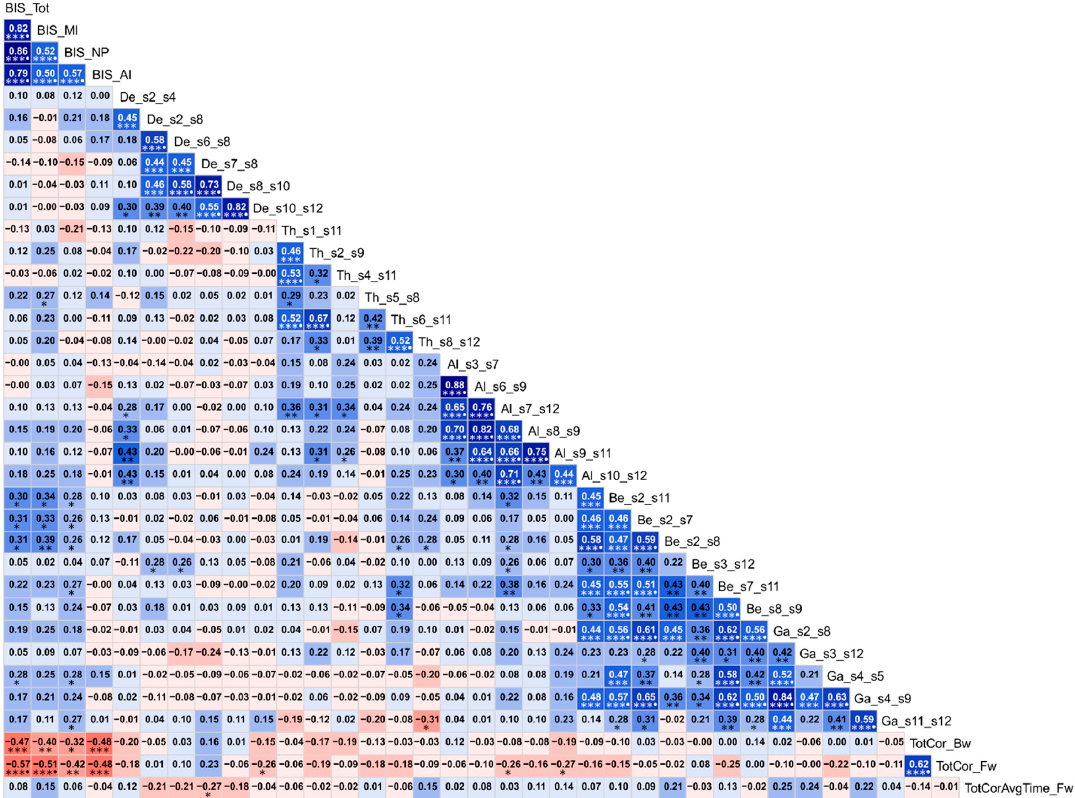
Figure 7. Correlation matrix showing associations among the top significant variables based on explorative (descriptive) correlational analysis for the interpretative purpose. Values within each cell represents bivariate Pearson correlation between the variable on its vertical axis and the variable on its horizontal axis. Correlation values are color coded [red/pink shades represent negative r-values, blue/cyan shades indicate positive r-values, darker color represent higher magnitude] and significant correlations (before Bonferroni correction) have been marked with asterisks [* p < 0.05; ** p < 0.01; and *** p < 0.001]. The correlations that survived Bonferroni correction ( r ≥ 0.50 and p < 0.00005) have been marked with a filled circle at the end of triple asterisks (*** ● ). Abbreviations in the variable labels: De –